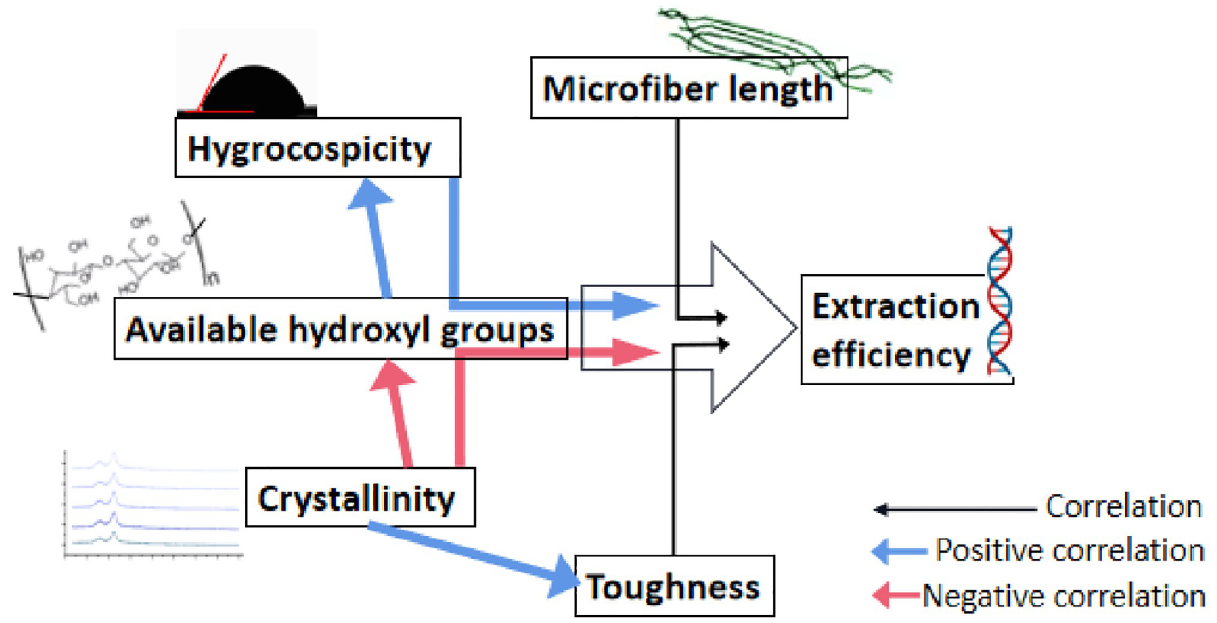
Fig 8. The correlation